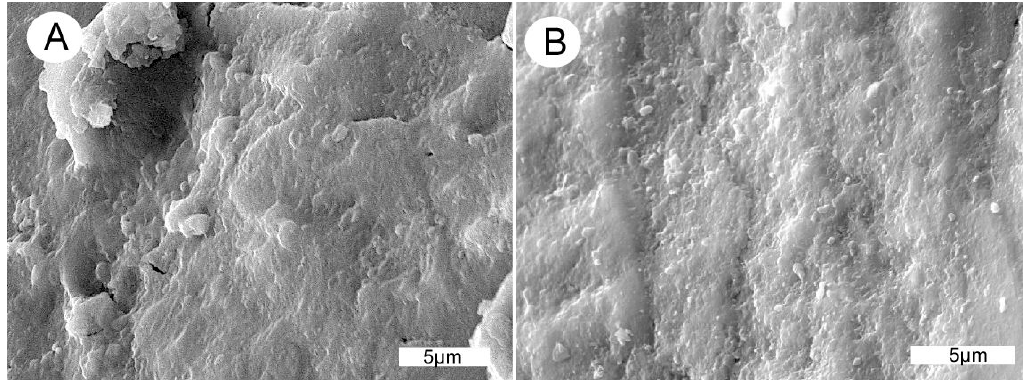
Figure 17. ( A) Opal-A, Meshgin Shahr specimen T-2 (trunk 2). ( B) Presumed relict opal-A texture in quartz-mineralized wood, specimen T-12 (trunk 7).